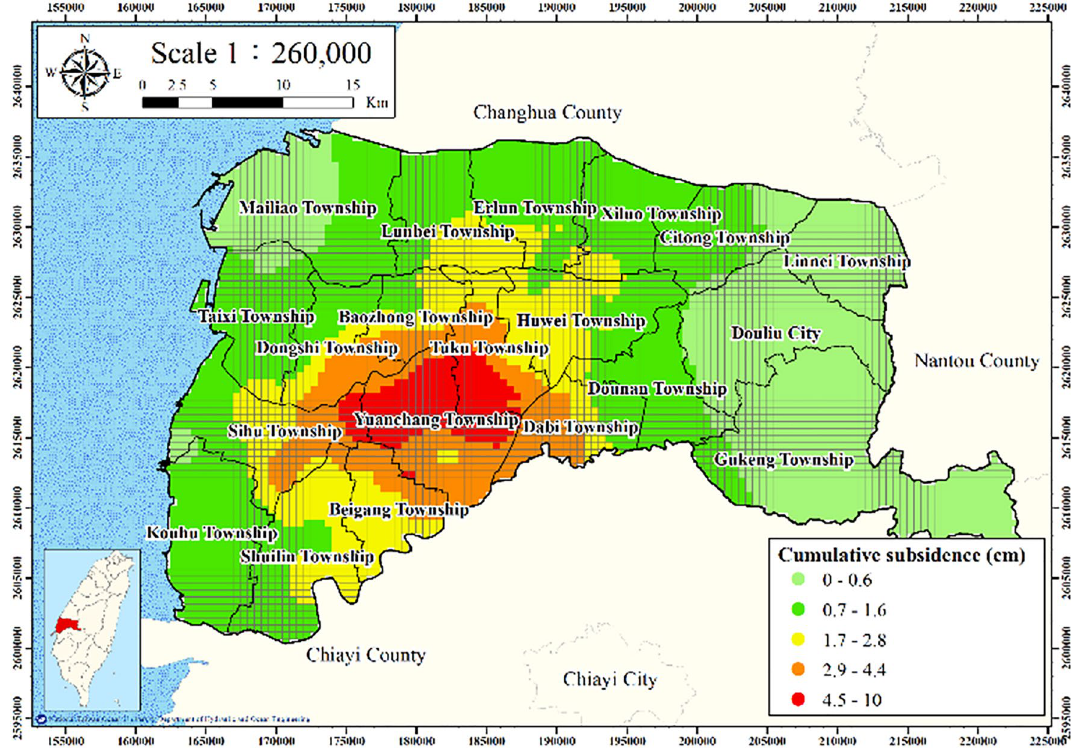
Figure 15. Cells of accumulated subsidence. This figure was created using ArcGIS 10.6.1 software.